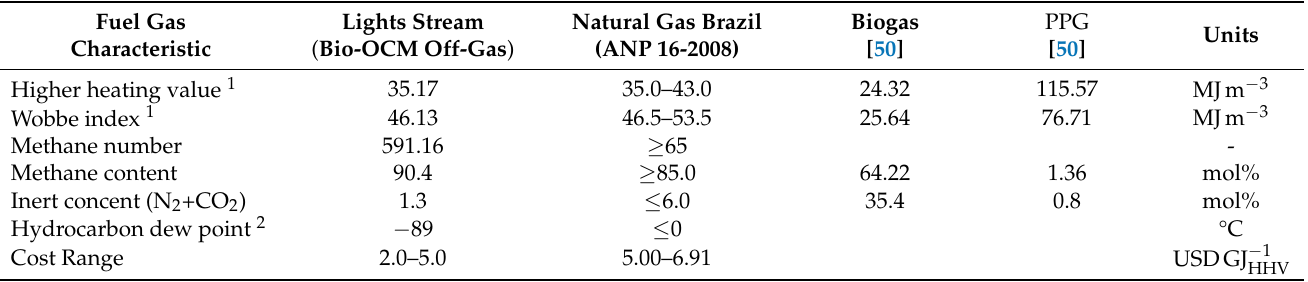
Table 2. Characteristics of the light gas steam side-product of the Bio-OCM process in comparison with pipeline natural gas specifications from Brazilian standard ANP 16-2008 and other fuel